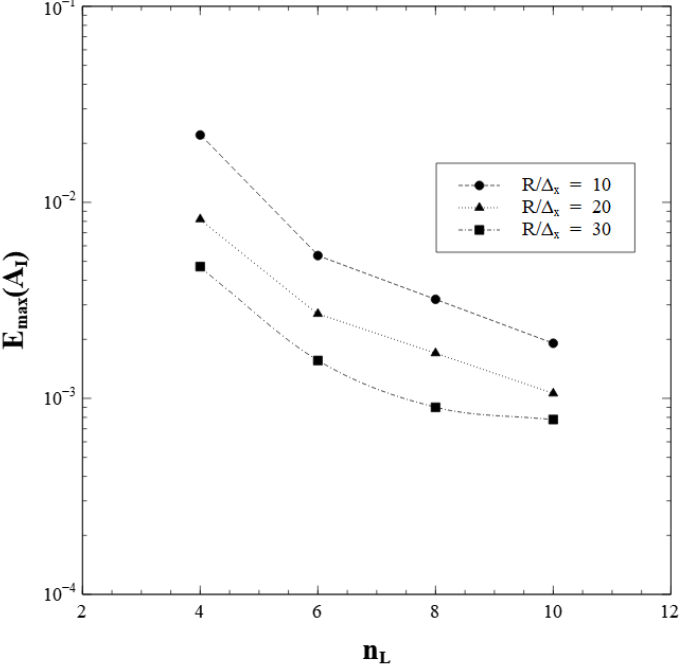
Figure 8. Maximum relative interfacial area errors along a circular interface as a function of n L and the mesh